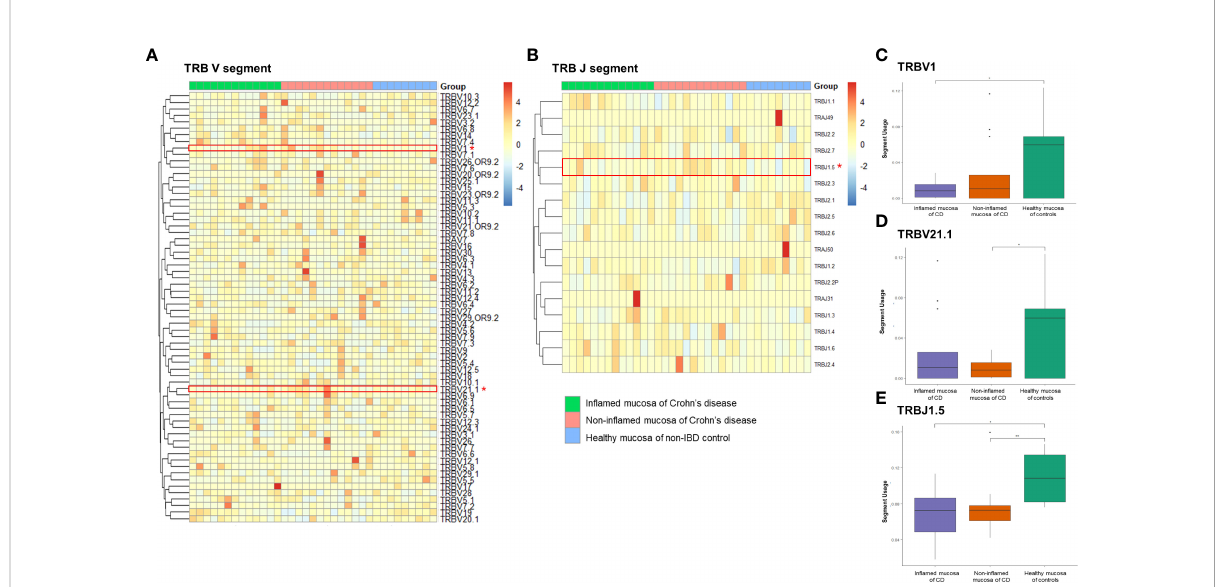
FIGURE 6 Expression frequency of TCR b variable (TRBV) and junctional (TRBJ) segments. Heatmap for (A) TRBV and (B) TRABJ segment expression. Red dot and line indicate differentially expressed TRAJ segments. (C) TRBV1 segment usage, (D) TRBV21.1 segment usage, and (E) TRAV2 segment usage. * p < 0.05 and ** p < 0.01.